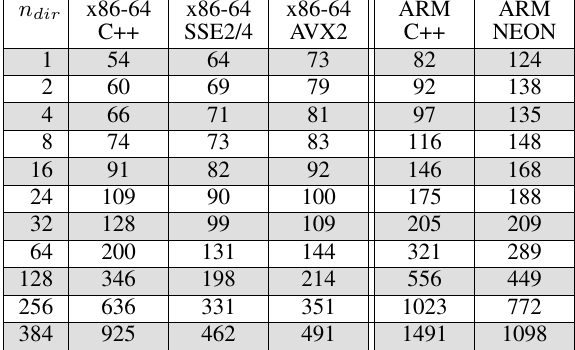
Table 4. Runtime in seconds for the SGM implementation on Intel x86-64 and ARM v7